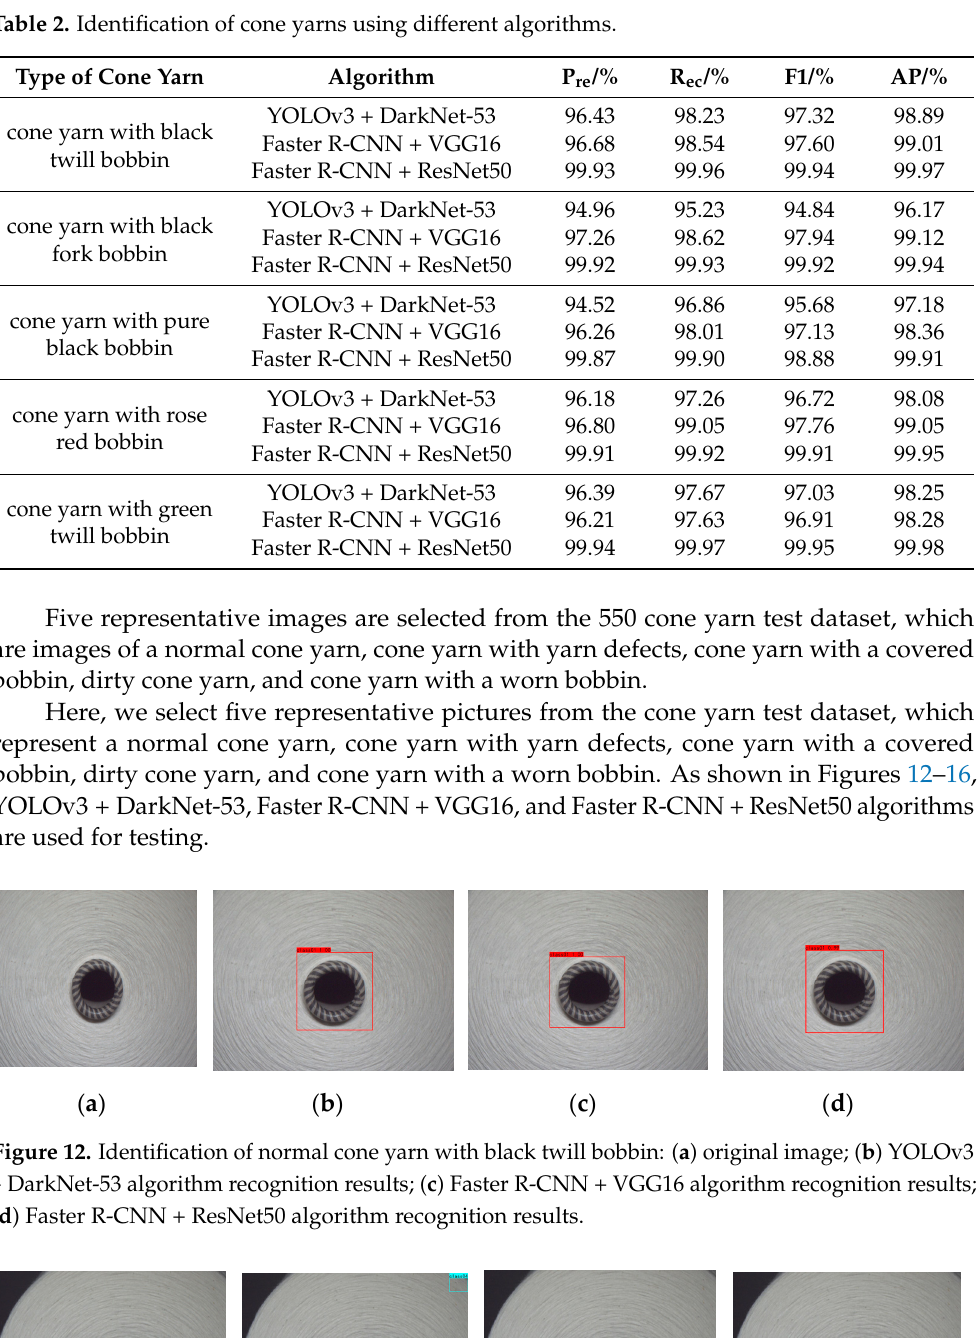
Figure 13. Identification of cone yarn with yarn defects: ( a ) original image; ( b ) YOLOv3 + DarkNet-53 algorithm recognition results; ( c ) Faster R-CNN + VGG16 algorithm recognition results; ( d ) Faster R-CNN + ResNet50 algorithm recognition results.